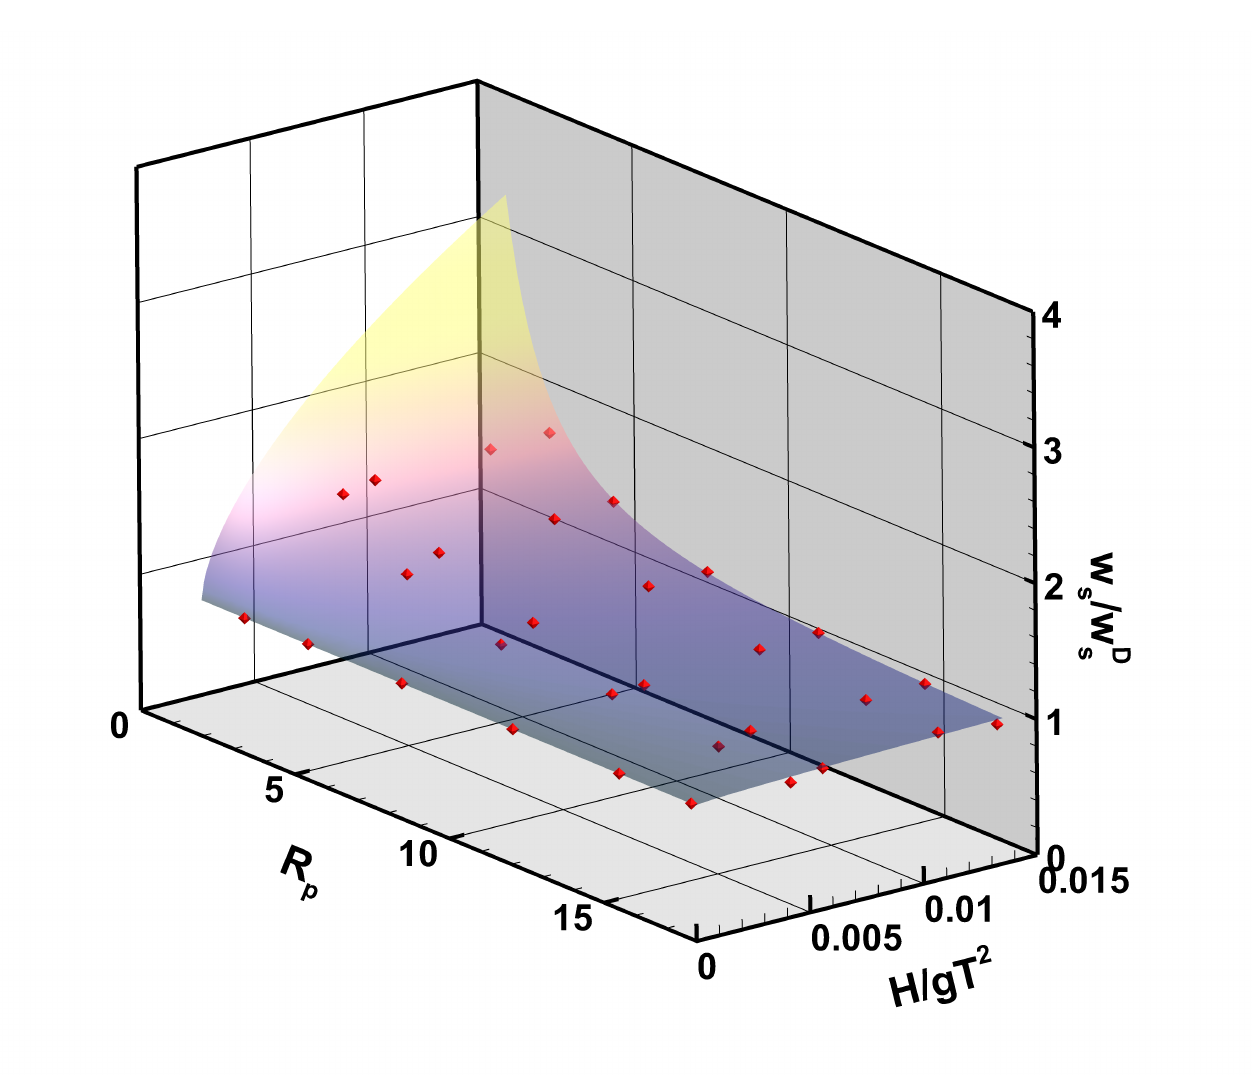
Figure 8. Reconstructed surface using Equation (7) in the parameter space ( R p , H / gT 2 ) versus the experimental net settling